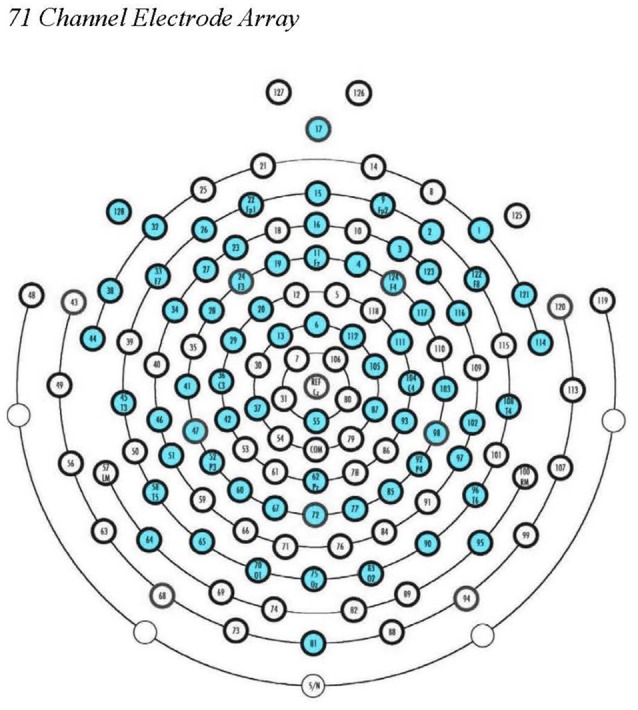
EGI 128-channel Hydrocel Geodesic Sensor Net. The 71 source electrode locations used in our ROI calculations in eLORETA are noted in blue.